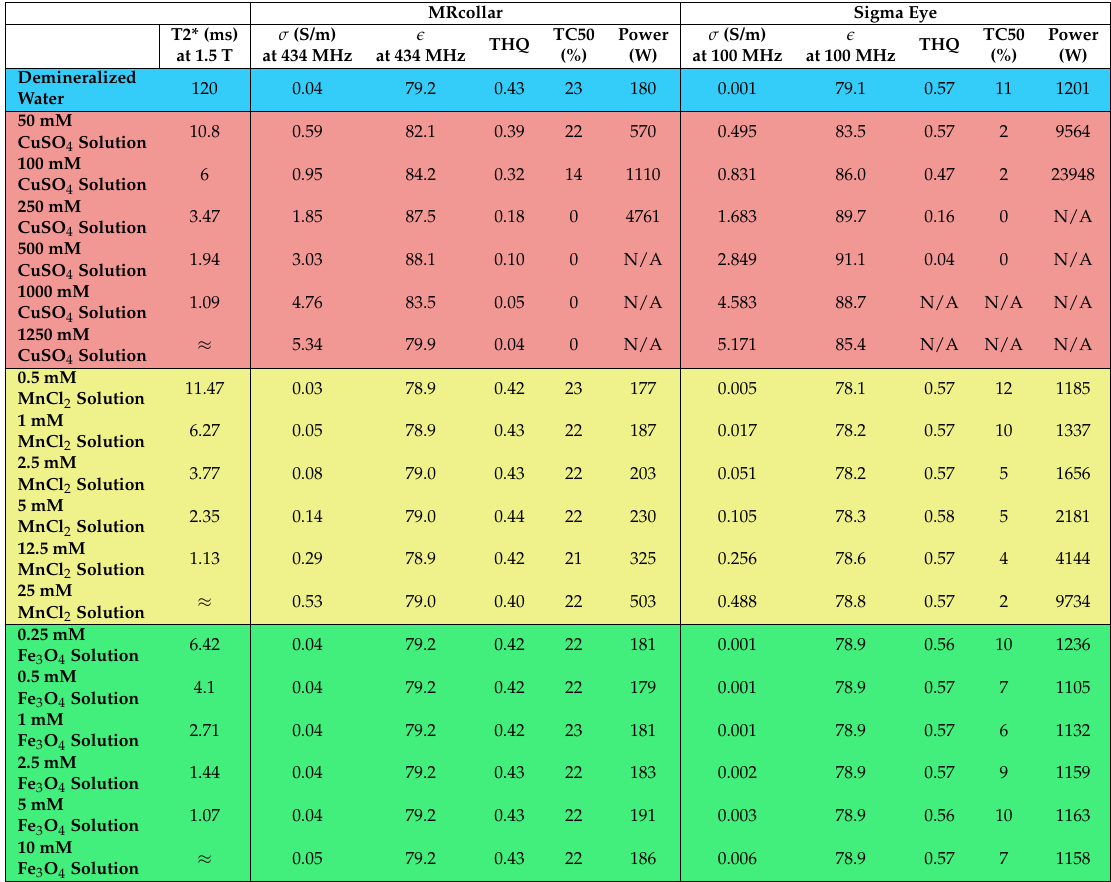
Table 1. T 2 * at 1.5 T, conductivity and relative permittivity of demineralized water and different water solutions at 100 and 434 MHz, and their effect on hyperthermia treatment planning parameters target-to-hotspot quotient (THQ), the target coverage of the 50% iso-SAR volume (TC50 [%]) and required power to reach 44 ◦ C in the healthy tissue (Power [W]) for two different MR compatible RF hyperthermia devices. T 2 * values donated with ≈ are not fitted due to low